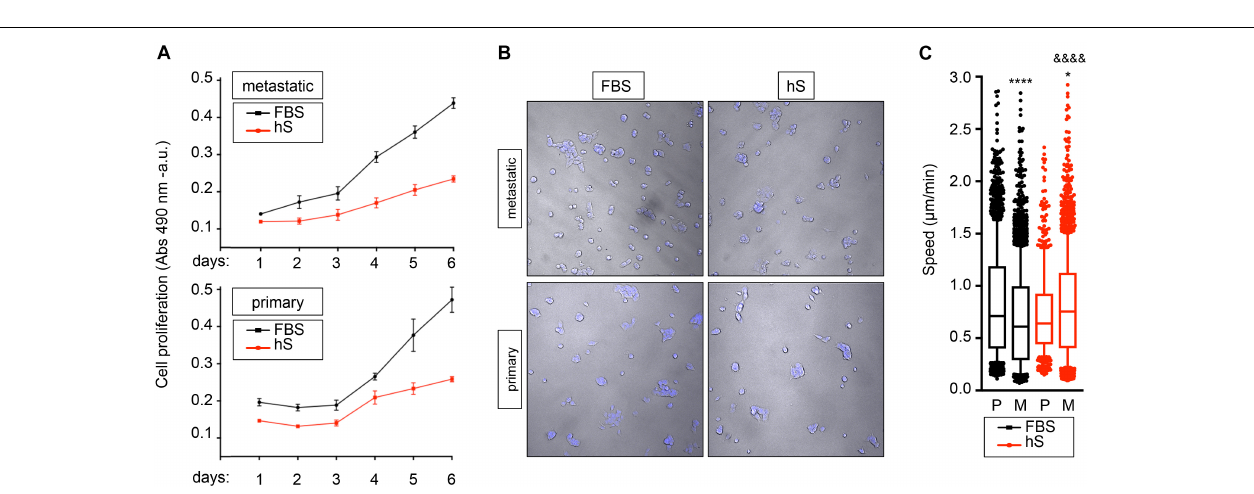
FIGURE 4 | Study of proliferation and migration speed of Ewing’s sarcoma cells cultured in FBS and human serum. (A) MTS assay for analyzing cancer cell growth of metastatic (SK-MC) and primary (RD-ES) Ewing’s sarcoma cell lines ( n = 3–4). Culture medium was supplemented with FBS or human serum (hS). Indicated cells were cultured over 6 days in monolayer. (B) representative images of metastatic and primary Ewing’s sarcoma cell lines stained with Hoechst 33342 at indicated culture media in monolayer. (C) Box-and-whiskers plot with all of the raw data obtained from LEVER and overlaid to show primary and metastatic cell migration speed under specified conditions. The median is shown by the line bisecting the box. The whiskers represent 10th and 90th percentiles of the data Statistical analysis comparing median speed between conditions is performed using Mann- Whitney test (unpaired, two-tail distribution; confidence level 95%.). Metastatic FBS vs. primary FBS p value < 0.0001; p value summary ****. Metastatic hS vs. primary hS p value = 0.0227; p value summary *. Metastatic hS vs. metastatic FBS p value < 0.0001; P value summary &&&& . Primary hS vs. primary FBS p value = 0.0738; p value summary = n.s., not